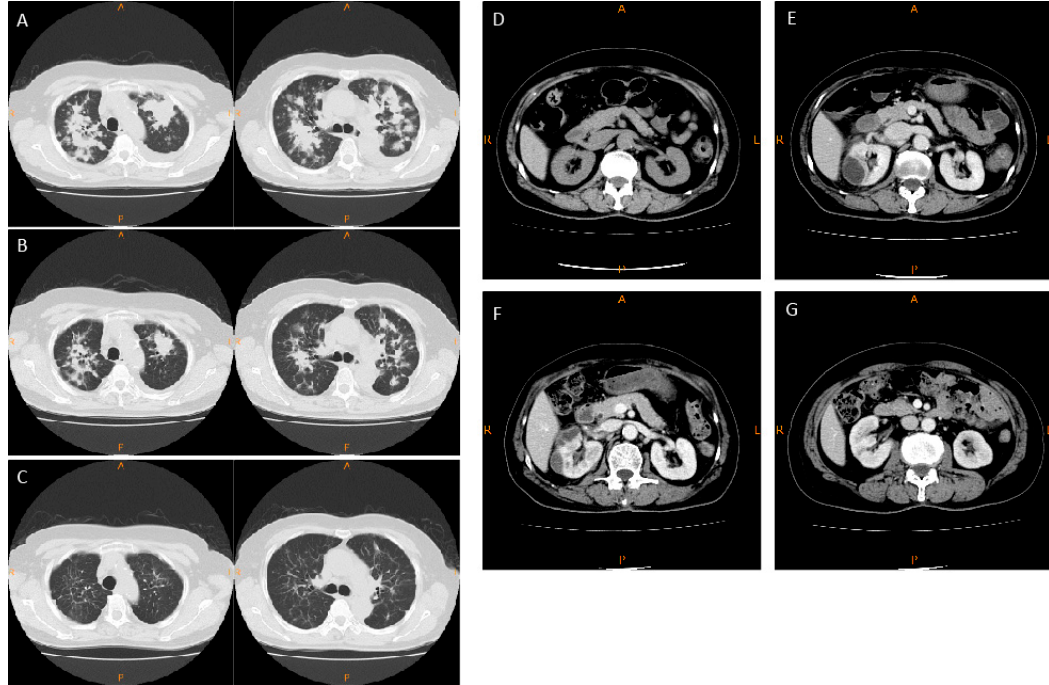
Figure 1. Chest and abdominal computed tomography (CT) in the present case. Chest CT of the patient with ALK -positive NSCLC at diagnosis ( A ), after 1 month ( B ), and after 11 months ( C ) of crizotinib therapy. Abdominal CT of the patient before therapy with crizotinib ( D ), 11 months after crizotinib therapy ( E ), 13 months ( F ) after crizotinib therapy, and after stopping the drug ( G ). NSCLC: non–small cell lung cancer; ALK : anaplastic lymphoma kinase.